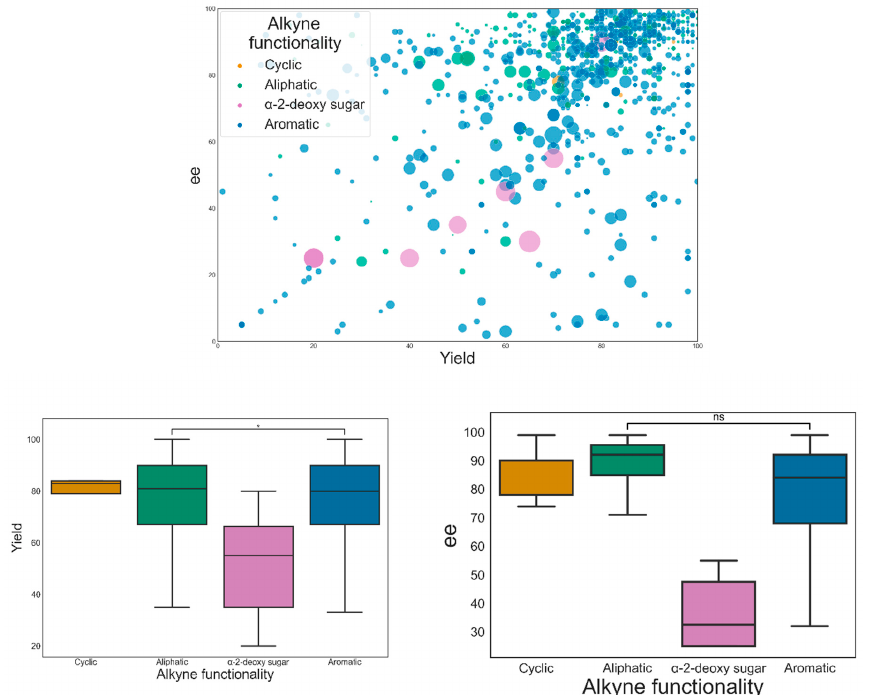
Figure 15. ( upper ) Distribution of alkynes with enantioselectivites greater than 0. ( lower ) Yield of alkynes with different functionalities. Statistical analysis was performed using Student’s t -test ( p = 0.023) ee of aldehydes with different functionalities. Statistical analysis was performed using Student’s t -test ( p = 0.015). Symbol Meaning: ns p > 0.05, * p ≤ 0.05 (For the last two choices only)